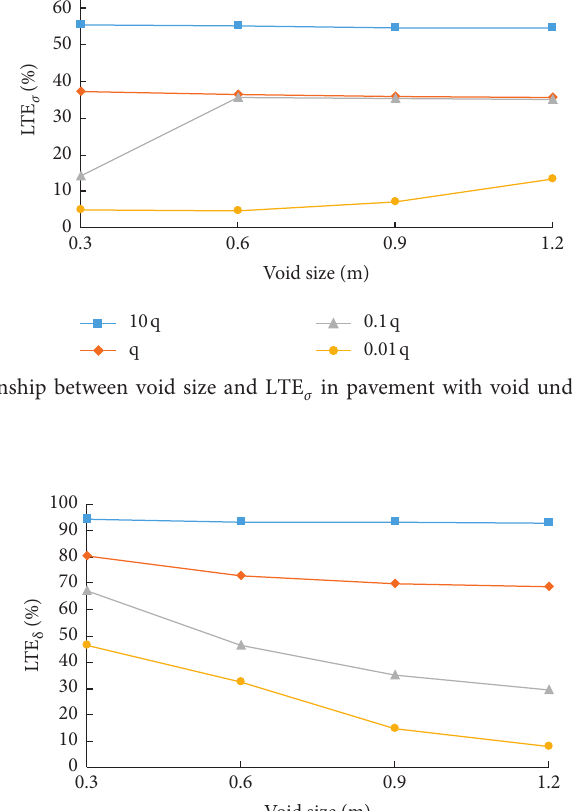
in pavement with void underneath loaded δ